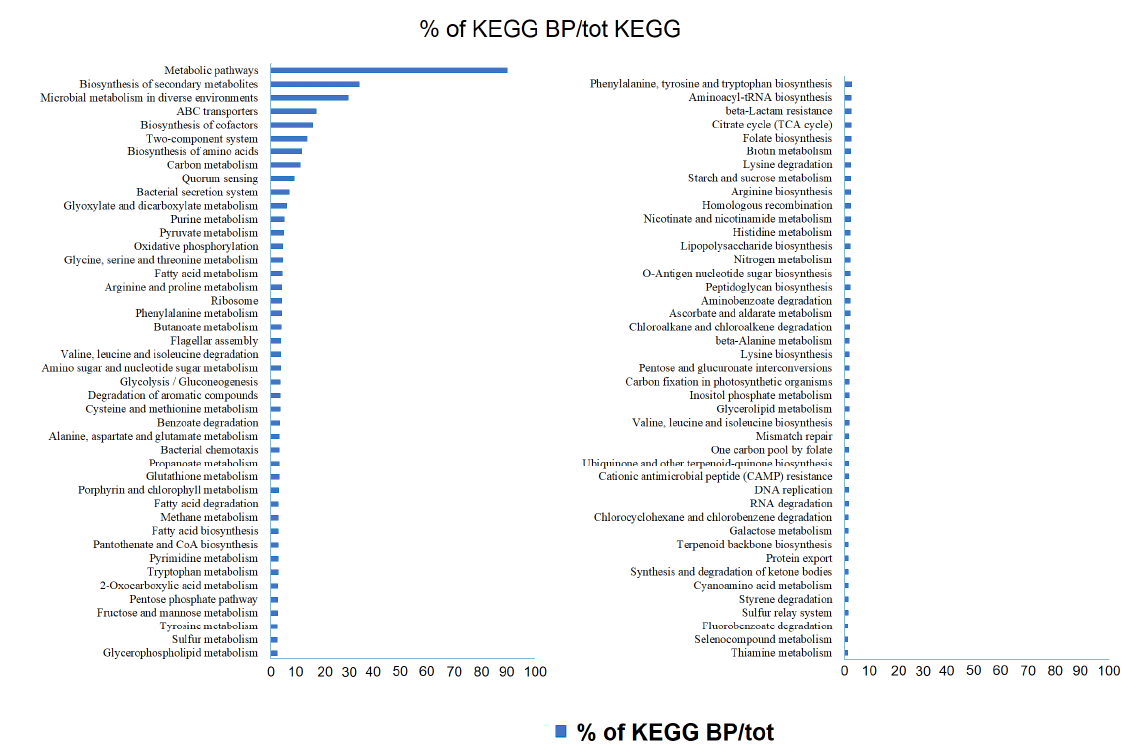
Figure 5. Percentages of unique KEGGs on the total retrieved KEGGs related to predicted biological processes (abundance >0.01%).